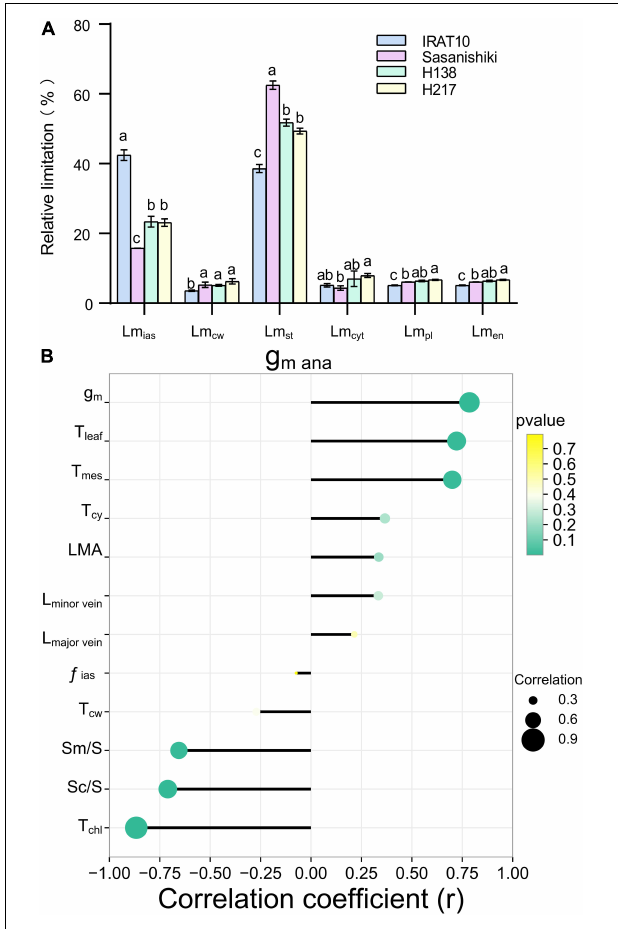
FIGURE 2 | Limitation analysis of modeled mesophyll conductance and the relationship between mesophyll conductance and leaf anatomical traits. Quantitative analysis of each component of modeled mesophyll conductance (g m ana ) in the flag leaves of tested varieties (A) . The limitation derived from the gas phase components (Lm ias ), mesophyll cell wall (Lm cw ), the stroma (Lm st ), the cytoplast (Lm cyt ), the plasmalemma (Lm pl ), and the chloroplast envelope (Lm en ) were quantified according to Tosens et al. (2016). Values are means ± standard error. Different letters indicate significant statistical differences among tested varieties at the 0.05 probability level. Relationship between mesophyll conductance and leaf anatomical traits (B)